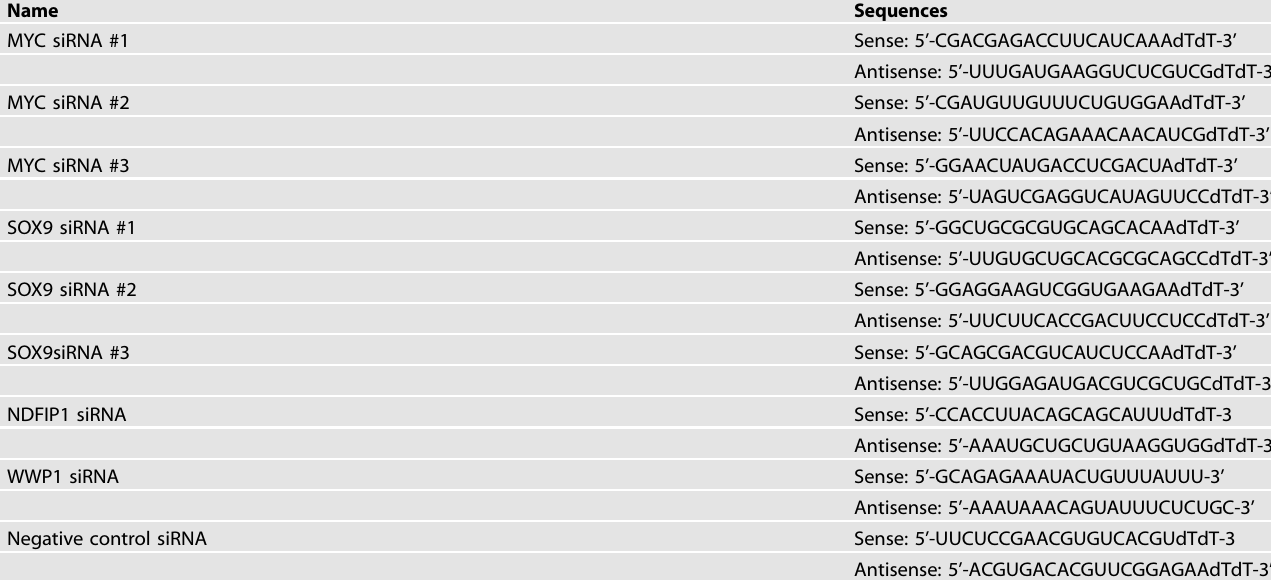
Table 2. Sequences of small interference